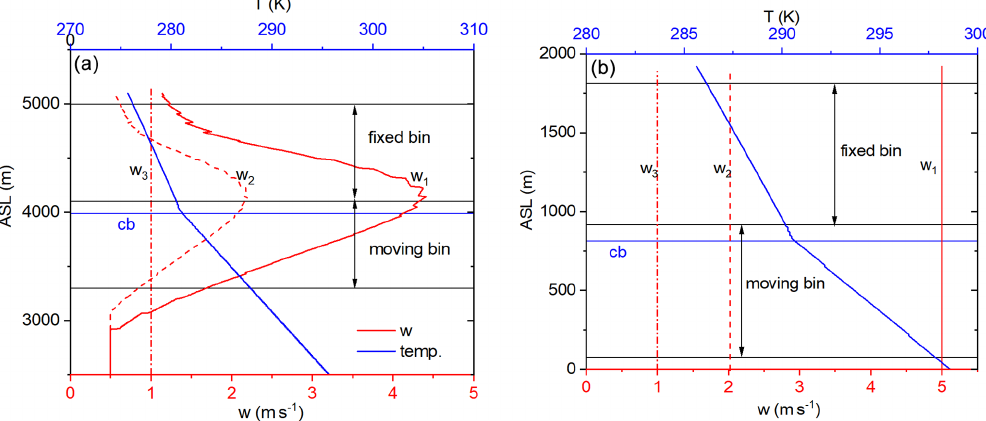
Figure 1. The simulated temperature profiles and the prescribed updraft profiles in the numerical simulation for (a) the SPEC UAE cases and (b) the QCSRP cases. The background aerosol particles are BGUAE_1 and BGQNC_1, and seeding materials are ICE70_2 and ICE70_4 in (a) and (b) , respectively. The plotted temperature profiles are calculated at the updraft profile of w 3 for each panel. The horizontal blue lines denote the altitude of the cloud base. The three horizontal black lines from bottom to top denote the level where the calculation of the diffusional growth starts (RH = 70%), the levels 100 and 1000m above the cloud